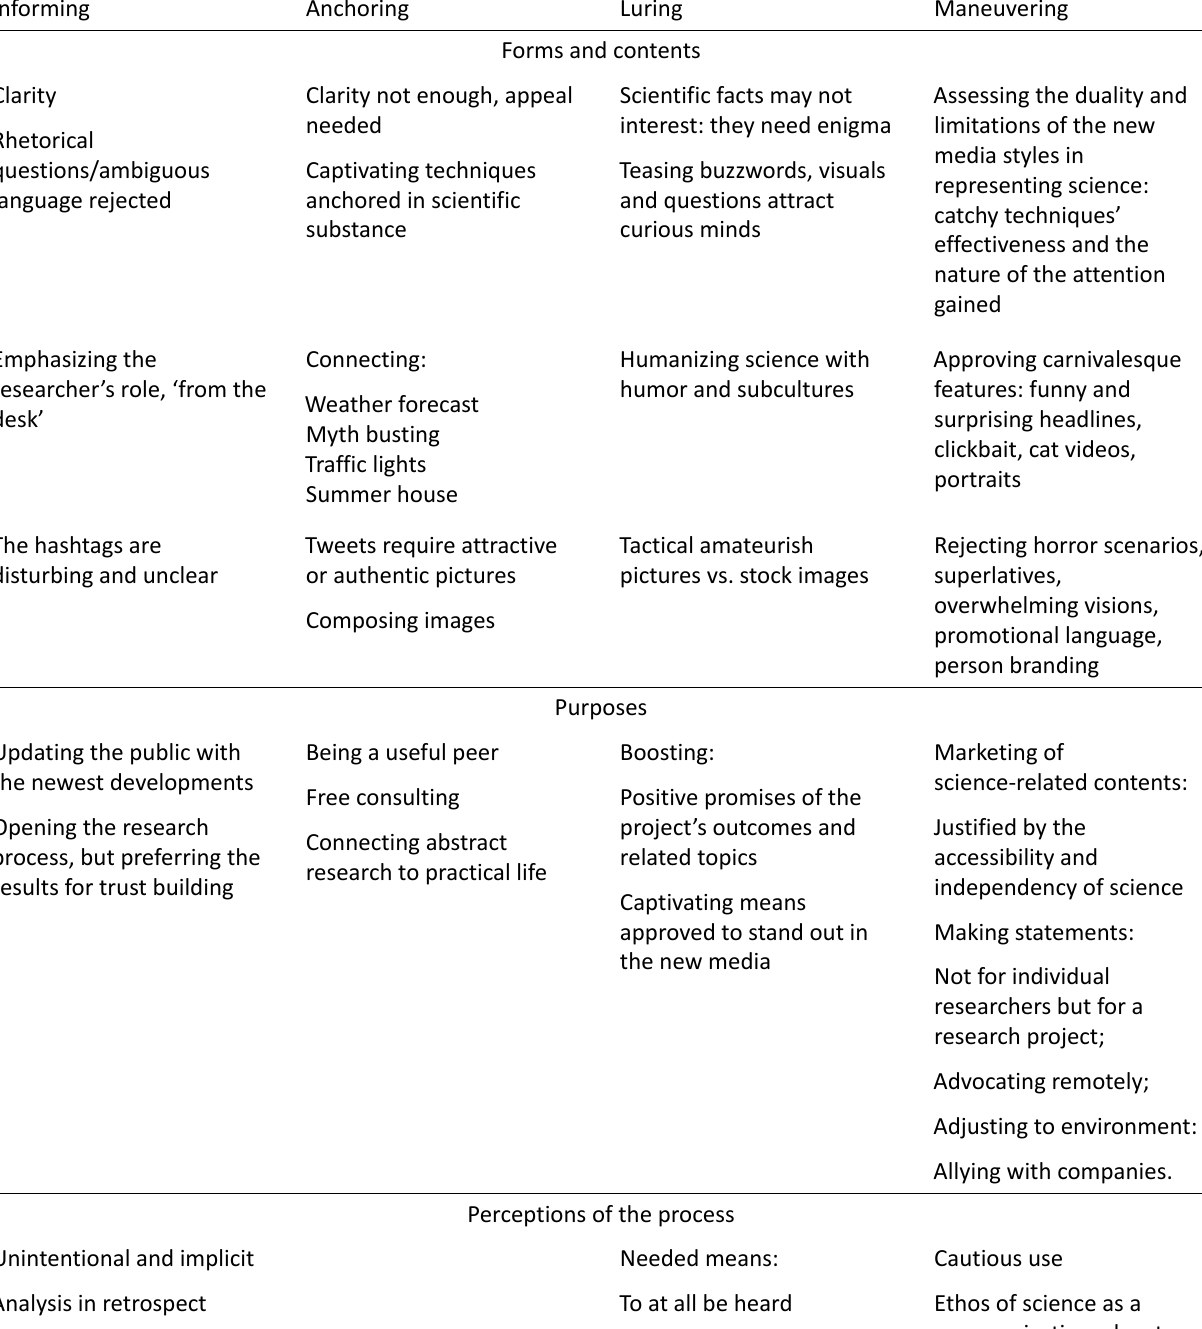
Table 1. Characteristics of digital academic discourse